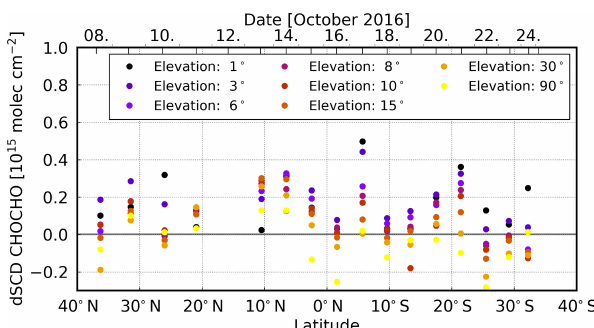
Figure 11. The latitudinal dependency (from north to south) of daily mean CHOCHO dSCDs over the Atlantic Ocean. On 13 and 14 Oc- tober, a different scan angle dependency is shown.